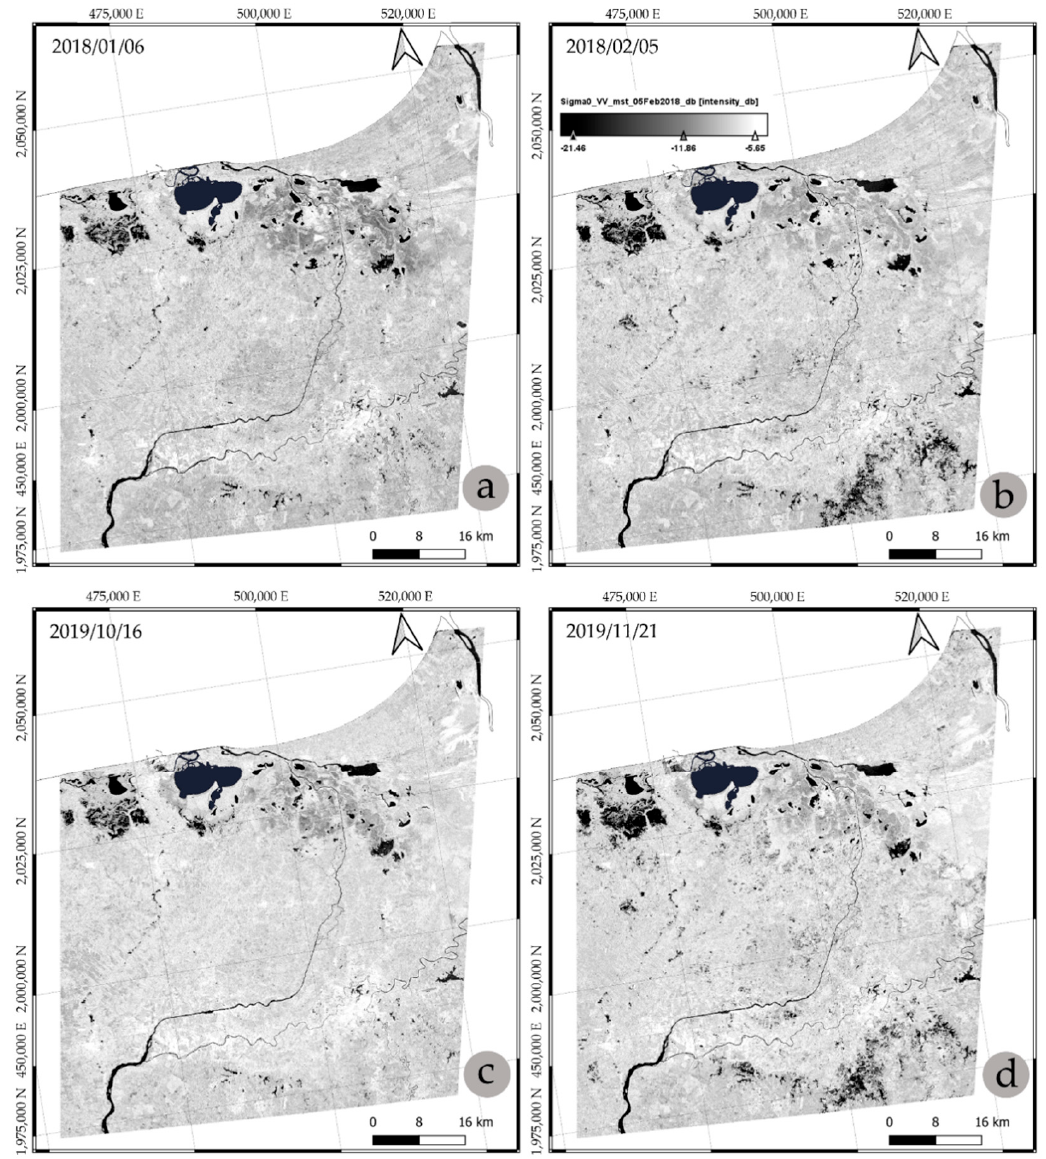
Figure 10. Sentinel-1 GRD intensity (in dB) of ( a ) 6 January 2018, ( b ) 5 February 2018, ( c ) 16 October 2019, and ( d ) 21 November 2019. ( a , c ) Correspond to the images before the flood event, and ( b , d ) to the images during the floods.